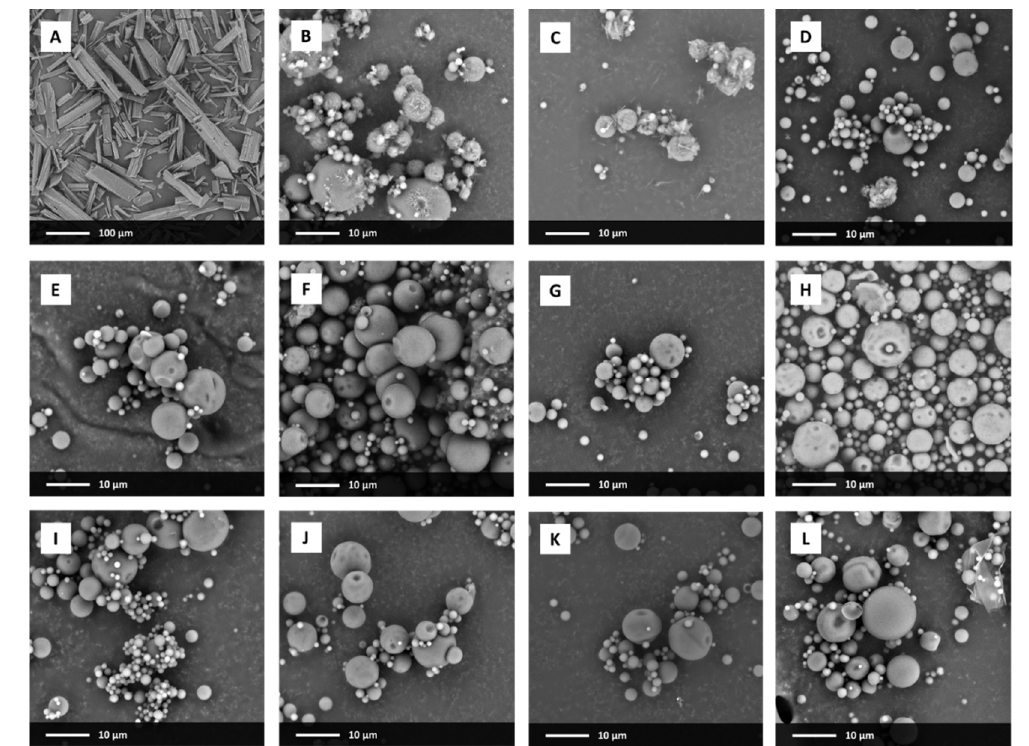
Figure 1. SEM images of raw ezetimibe ( A ), drug spray-dried without a carrier ( B ) and EZT-PVP/VA solid dispersions containing 5% ( C ), 20% ( D ), 25% ( E ), 33% ( F ), 40% ( G ), 50% ( H ), 66% ( I ), 75% ( J ), 80% ( K ) and 91% ( L ) of PVP/VA, respectively.